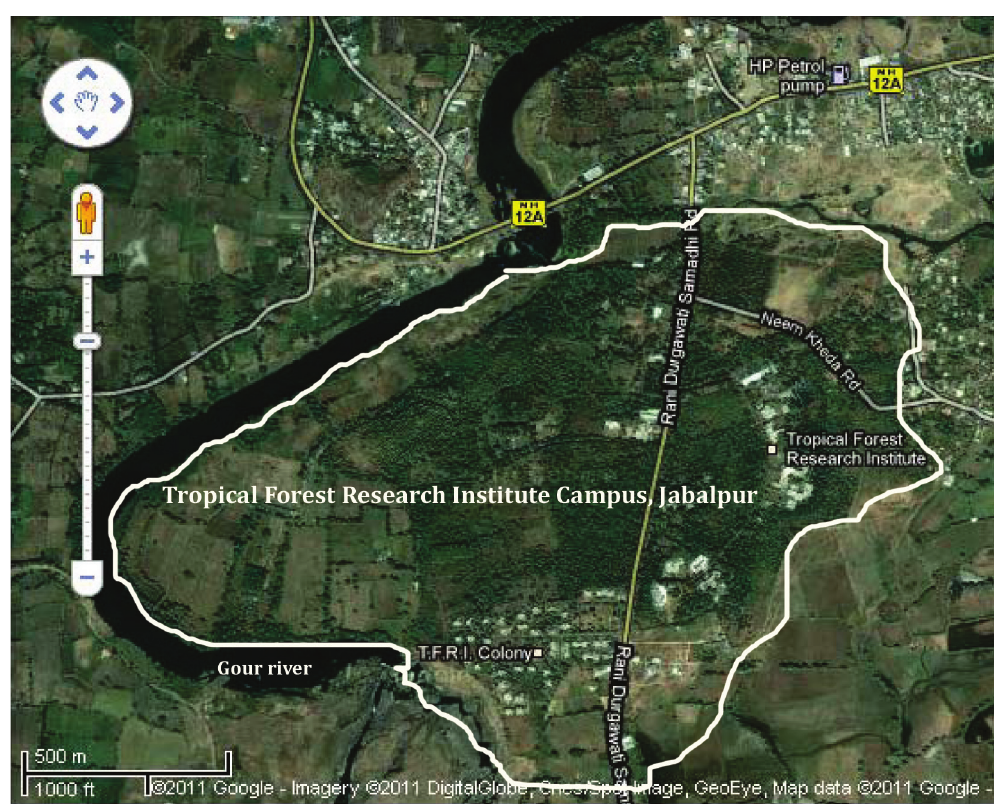
Image 1. Satellite overview map of study